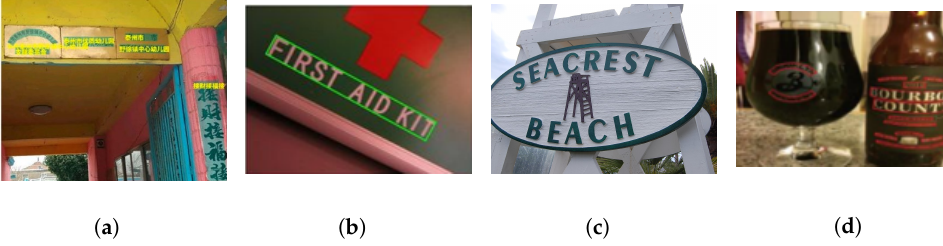
Figure 5. Image examples of publicly available datasets for scene text recognition. ( a ) ICDAR19- LSVT [59]. ( b ) MSRA-TD500 [60]. ( c ) CUTE80 [61]. ( d ) SCUT-CTW1500